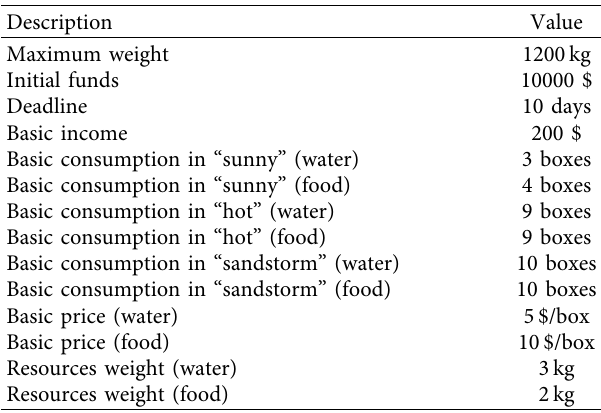
Table 5: Parameter setting.